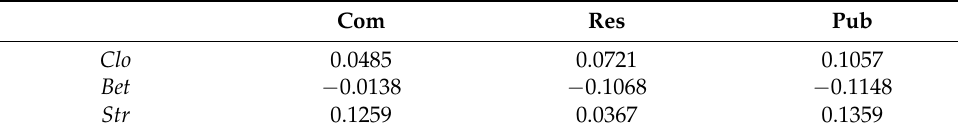
Table 5. Influence coefficient of SC on LUI. Com Res Pub Clo